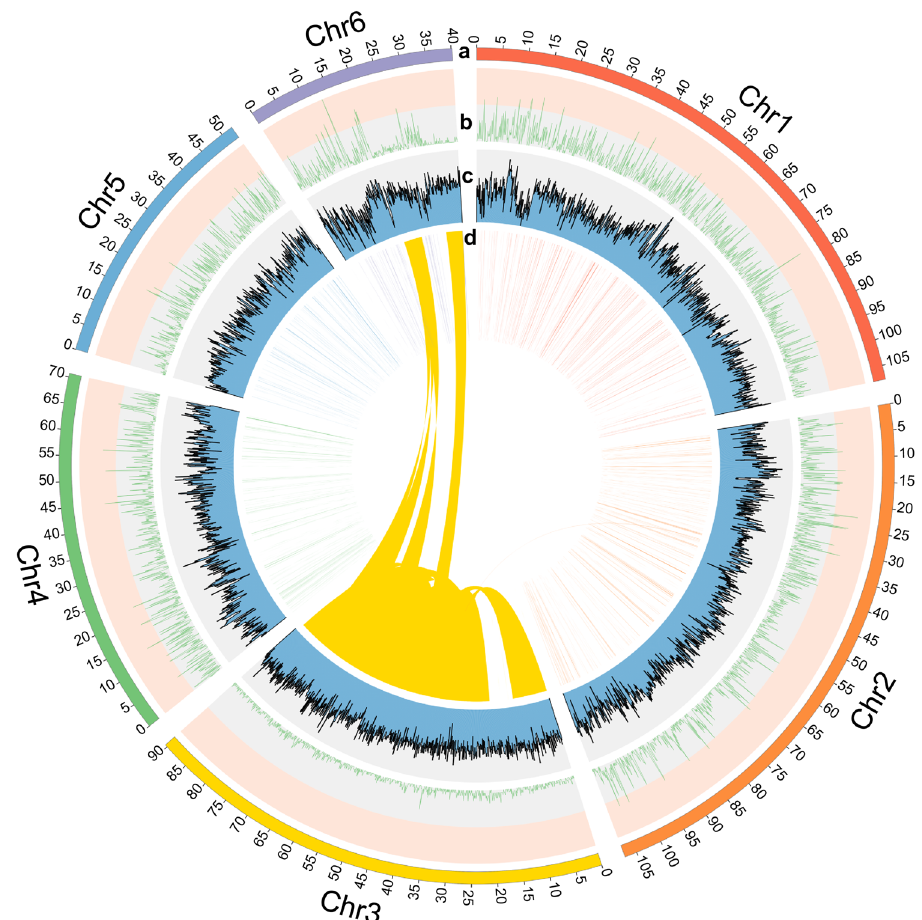
Fig. 1 Circular diagram depicting the characteristics of the Bactrocera dorsalis genome. From the outer to the inner circle: a Ideogram of the six B. dorsalis chromosomes at the Mb scale. b Gene density. c Guanine-cytosine (GC) content. d Collinearity block in the genome. Connecting lines at the centre of the diagram highlight the homologous relationships of